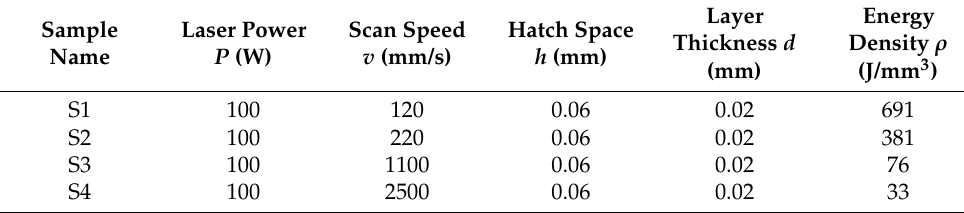
Figure 4. Optical micrograph of cross ‐ sections of LPBF ‐ built Ti ‐ Ta obtained at the four building parameters; ( a ): S1, ( b ): S2, ( c ): S3, ( d ): S4. The low ‐ magnification (70×) SEM images of the samples S1, S2, and S3 were shown in Figure 5a–c. Unmelted Ta particles (white particles in the figure) were found in the matrix. The imaging method was used to make statistics of unmelted Ta particles in the matrix. The unmelted Ta particles accounted for 0.7 vol.%, 5.1 vol.%, and 10.3 vol.% in samples S1, S2, and S3 respectively. The amount of the unmelted Ta particles was